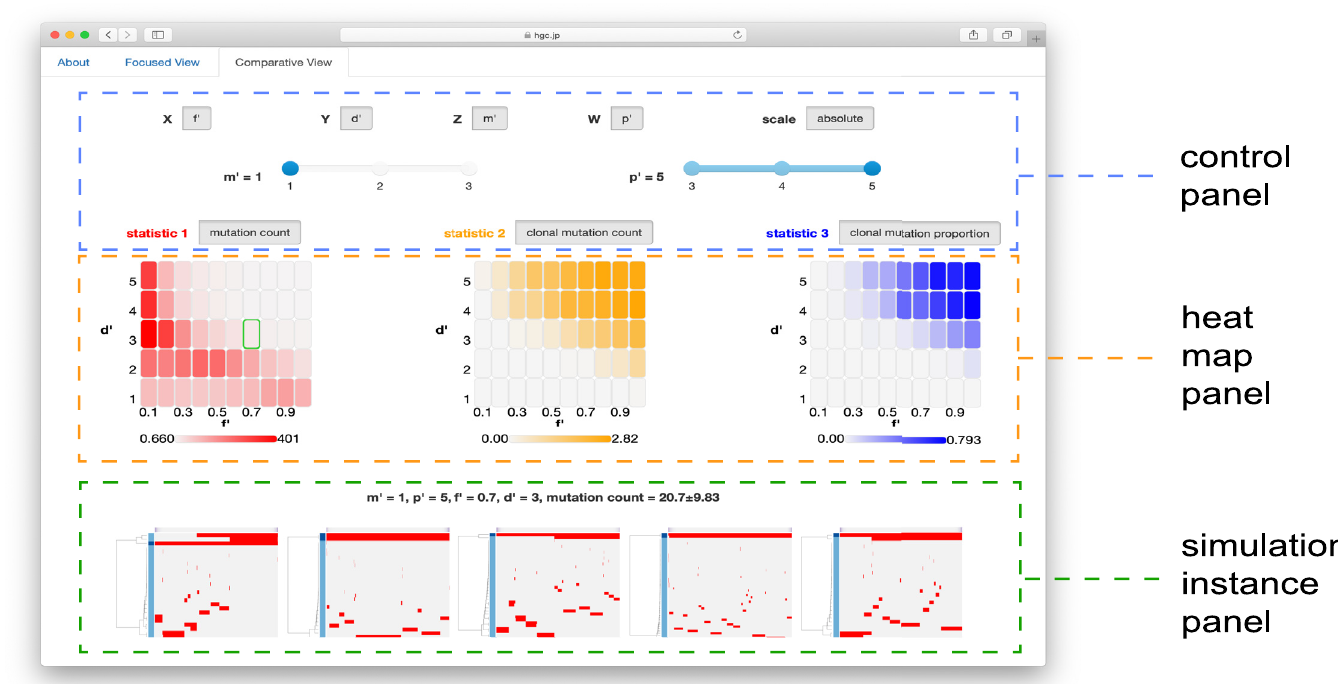
Fig 5. Comparative view mode of the MASSIVE viewer. Similarly to the focused mode, the page of the comparative view mode consists of control, heat map and simulation instance panels. Differently from the focused mode, the heat map panels present heat maps for three selected statistics.